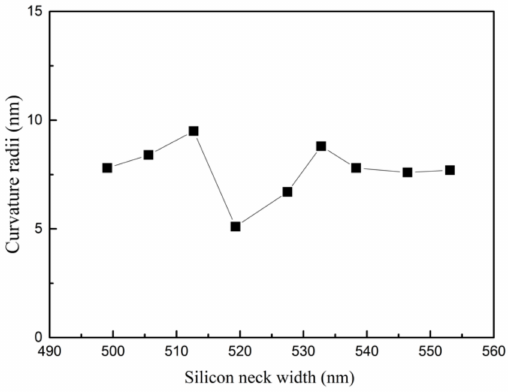
Figure 5. Curvature of the tip apex for the tip post with different neck widths.